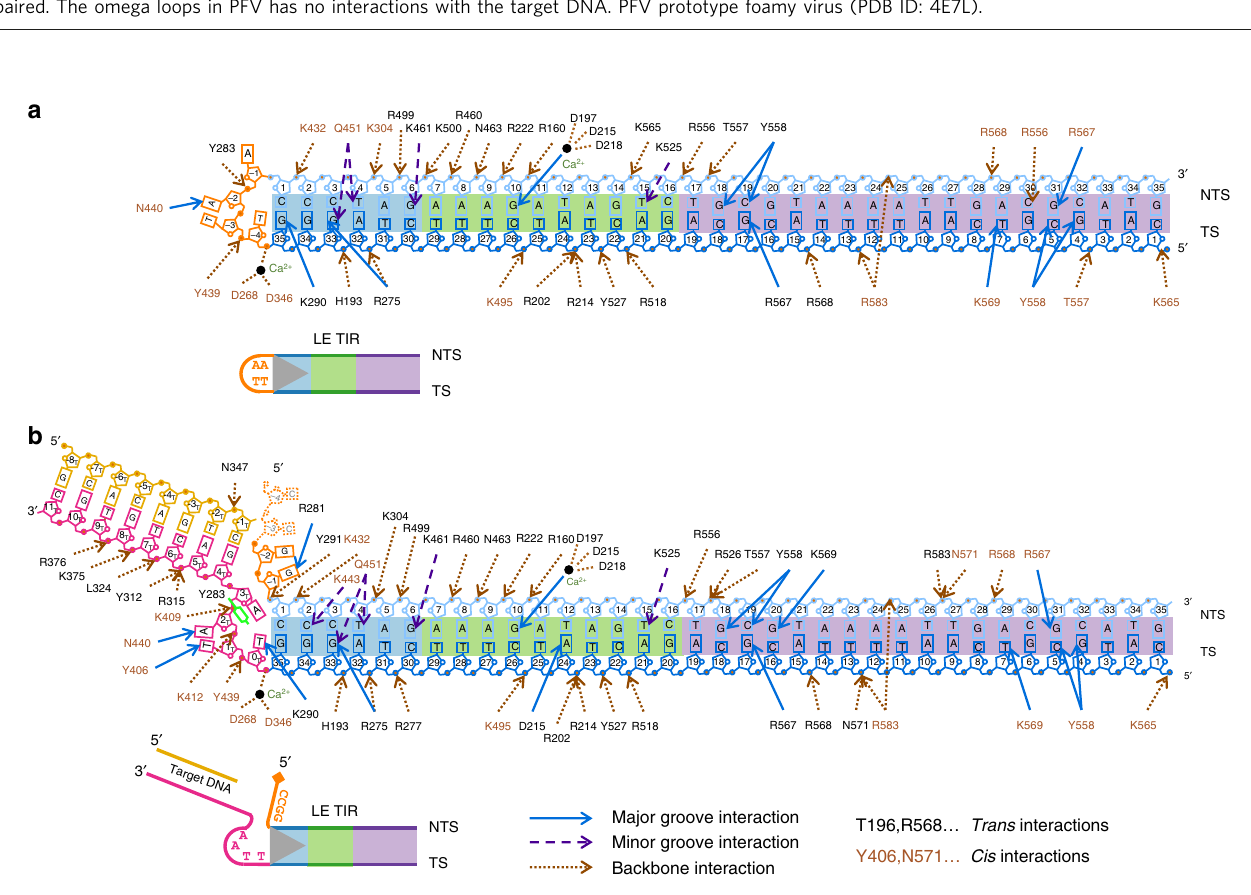
Fig. 4 SNHP and STC of PB reveal the mechanistic link between seamless excision and TTAA targeting. a Numbering system used for SNHP and STC DNA substrates. b , c Detailed protein – DNA interactions of TTAA tetranucleotides in the SNHP and STC. The interactions involve the omega loop (brown), the catalytic domain (green), and the insertion domain (purple). In STC, A3 T (equivalent to the fl ipped base A-1 in SNHP) is hydrogen bonded to T0 T , shown as a dashed line. For clarity, the NTS is not shown. Protein domains and DNA are colored as in Fig. 1d. d Superposition of the TTAA tetranucleotides in SNHP and STC. Except A-1 in SNHP and A3 T in STC, the other bases have similar conformations in both complexes. In the SNHP, A-1 is fl ipped out whereas, in the STC, A3 T is hydrogen-bonded to T0 T , represented as a black dashed line. e , f Comparison of target DNA integration of PB and PFV. PB binds and integrates into target DNA through the minor groove. Top, red triangles indicate staggered sites for integration (labeled as nucleotide T for PB and C for PFV) and the relative positions of the catalytic domains. The side view cartoons show how a PB dimer approaches target DNA towards the minor groove while PFV integrates through the major groove. Bottom, structure of the catalytic domains (green) interacting with target DNA. Due to severe distortion of the DNA backbone, the PB target site bases are unpaired, with two bases fl ipped out. Unlike in PB STC, the 4-bp PFV target site remains base- paired. The omega loops in PFV has no interactions with the target DNA. PFV prototype foamy virus (PDB ID: 4E7L).